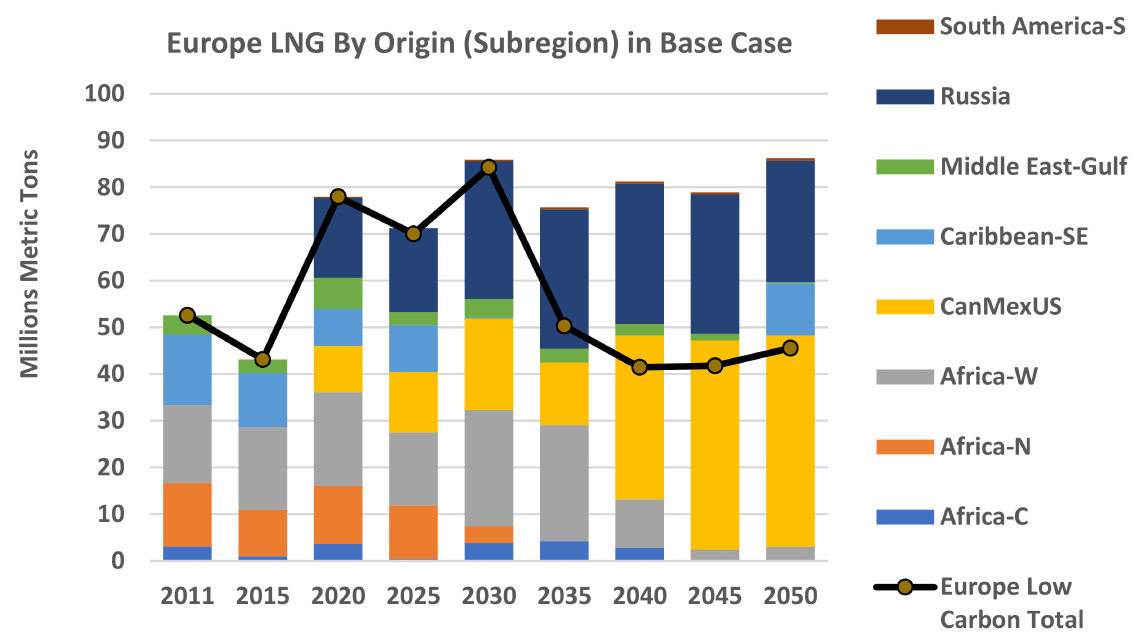
Figure 23. Europe net imports by pipeline and by LNG for base and low-carbon cases. Shown in Figure 24, in the base case, the Europe LNG imports market is expected to grow to around 86 million tons (110 BCM/4.8 tcf) per year by 2050. Europe diversifies its LNG sources from Russia, North America, North and West Africa, and the Middle East. In the low-carbon Europe case, LNG drops about 45 million tons (about 50%) versus the base case in Figure 25. The North America LNG import loses two-thirds of its volume in Europe after 2035.